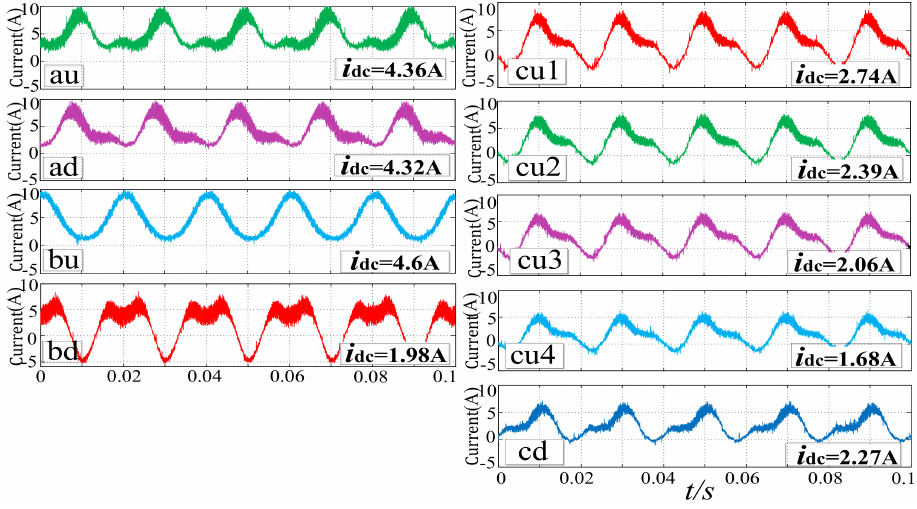
Figure 18. The currents of the battery modules.